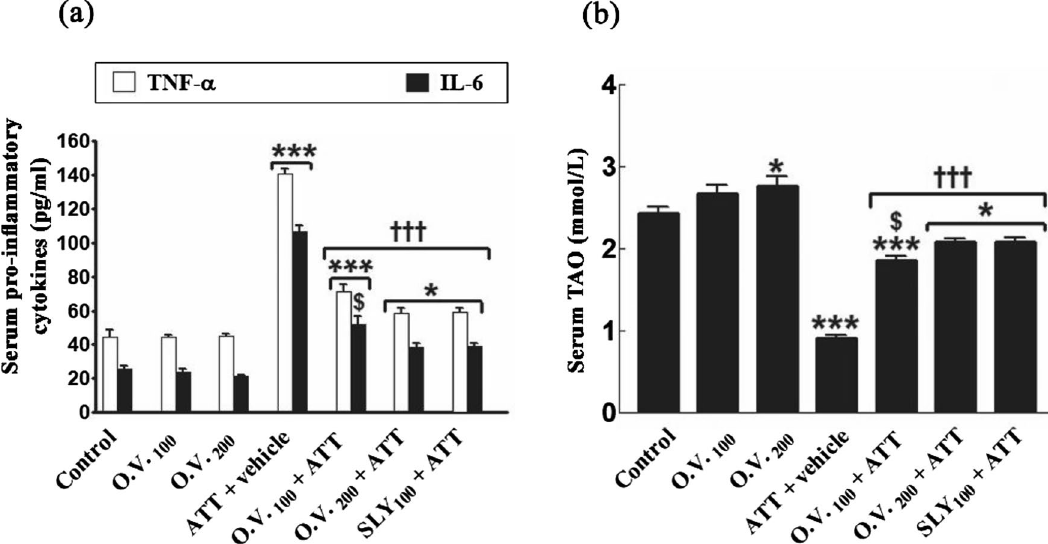
Figure 6. The modulatory effects of O. vulgare on serum pro-inflammatory cytokines ( a ) and total antioxidant capacity ( b ) in the HE-induced rat model. SEM represented by vertical bars. IL-6: interleukin-6, O.V . : Origanum vulgare , SLY: silymarin, TNF-α: tumor necrosis factor-alpha, TAO: total antioxidant. * p < 0.05; *** p < 0.001 (vs. the negative control group). ††† p < 0.001 (vs. the HE positive control group, which received vehicle). $ p < 0.05 (vs. the HE group, which received